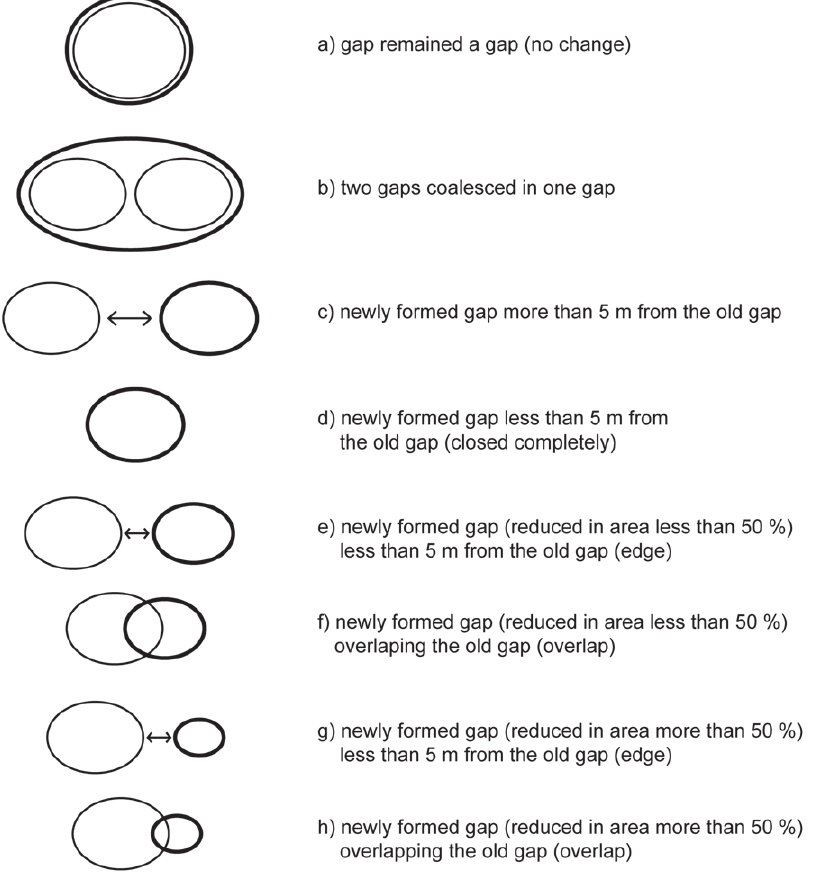
Figure 4. Gap formation processes (basic line represents gaps in the first measurement period, bold line represents gaps in the second measurement period).